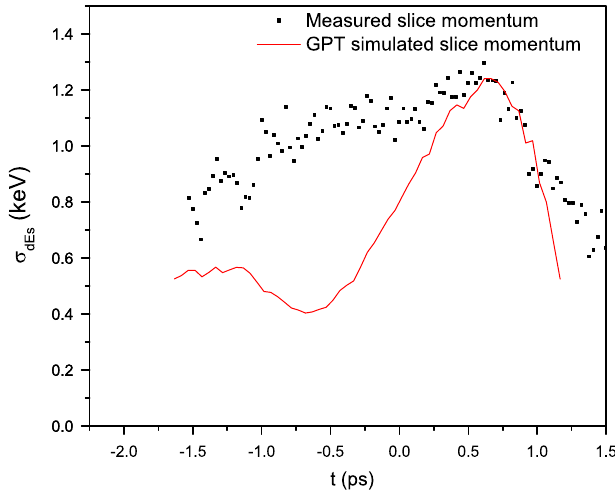
FIG. 4. (Color) The measured and simulated 50 fs slice energy spread along the bunch. The energy resolution of the measure- ment is limited to 1